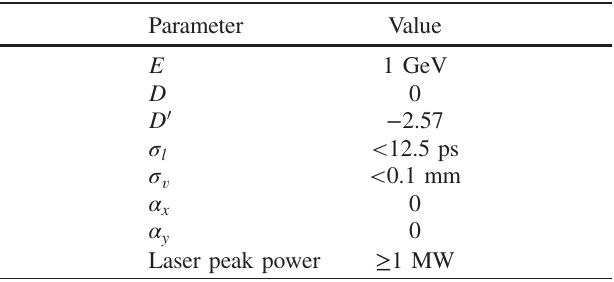
FIG. 5. Longitudinal beam size for production configuration (blue line) and the laser stripping configuration (red line). The dashed line indicates the position of the IP. The position s ¼ 0 corresponds to the beginning of the superconducting linear accelerator.